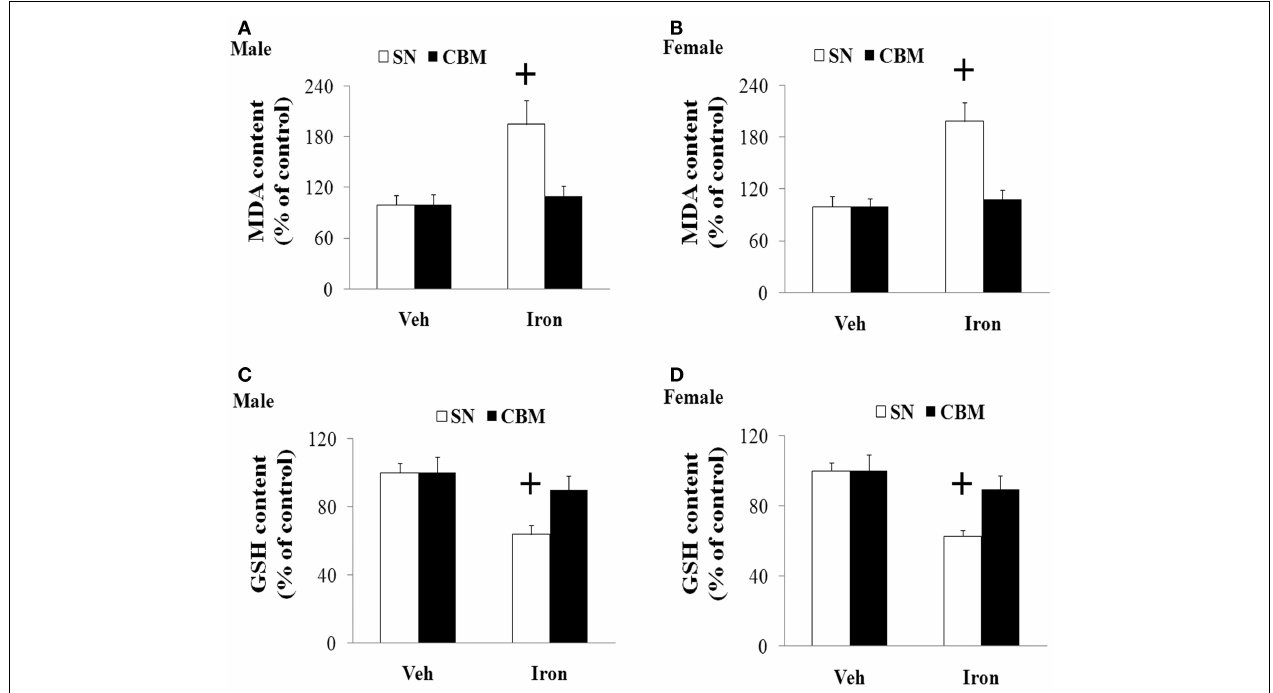
FIGURE 5 | Effect of increased neonatal iron intake on MDA (A,B) increase and GSH (C,D) content in the CBM of aging male (A,C) and female (B,D) rats with aging . Results are expressed as mean ± SEM. N = 8–10. + p < 0.005, compared with the aging rats treated with Veh. MDA, malondialdehyde; GSH, glutathione; SN, substantia nigra; CBM, cerebellum; Veh, vehicle.